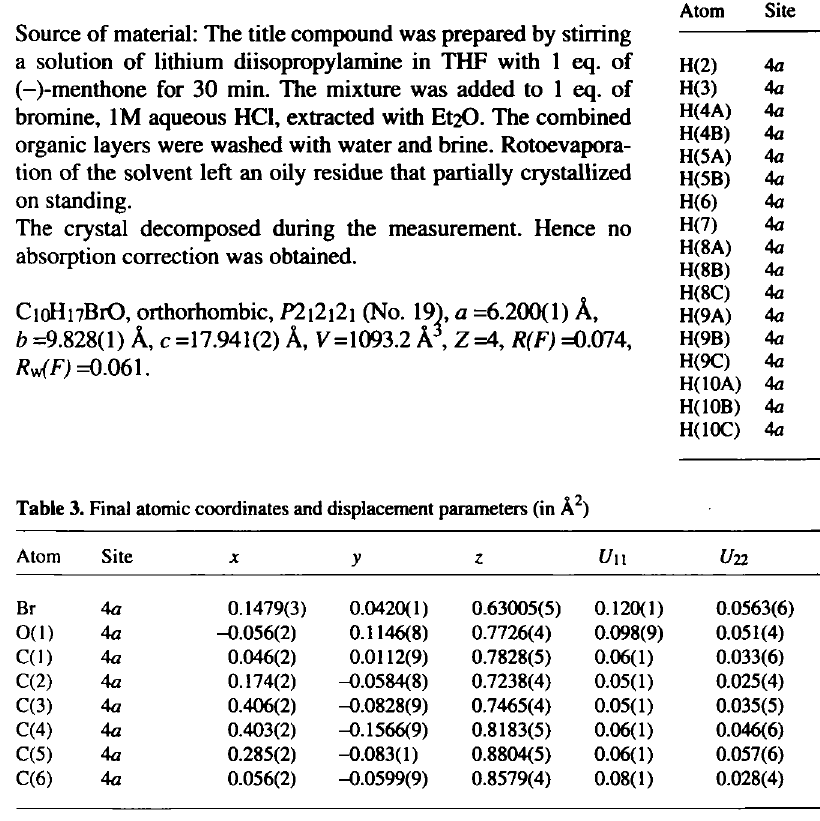
Table 2. Final atomic coordinates and displacement parameters (in